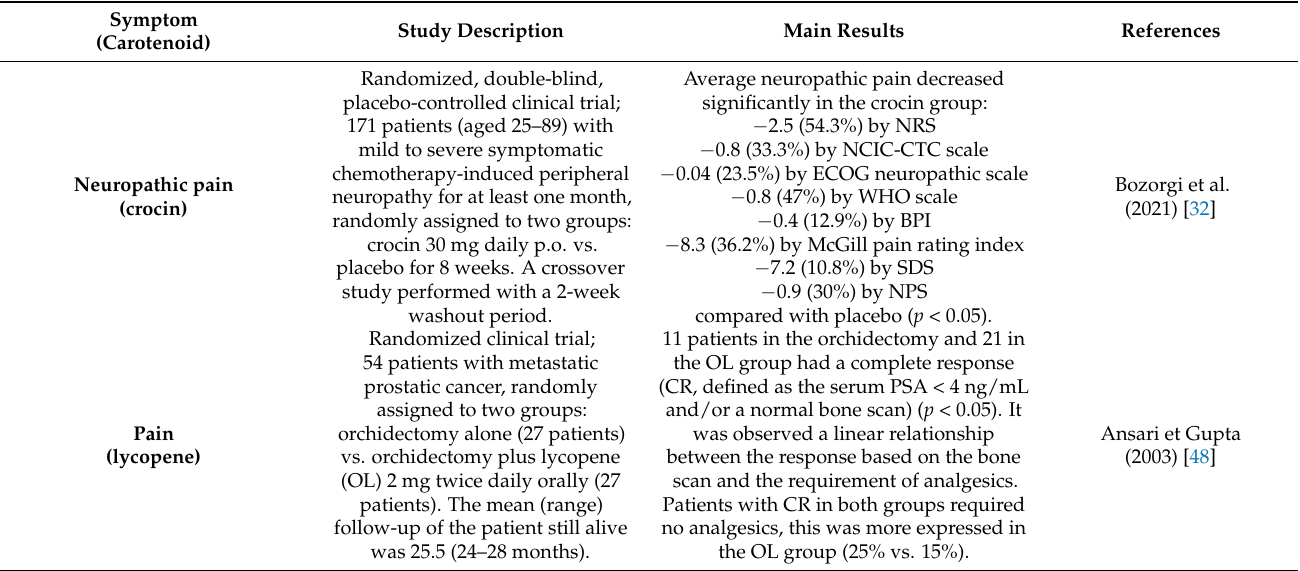
Table 2. Human studies on the effectiveness of carotenoids in alleviating cancer-related symptoms (neuropathic pain, cachexia) and frailty